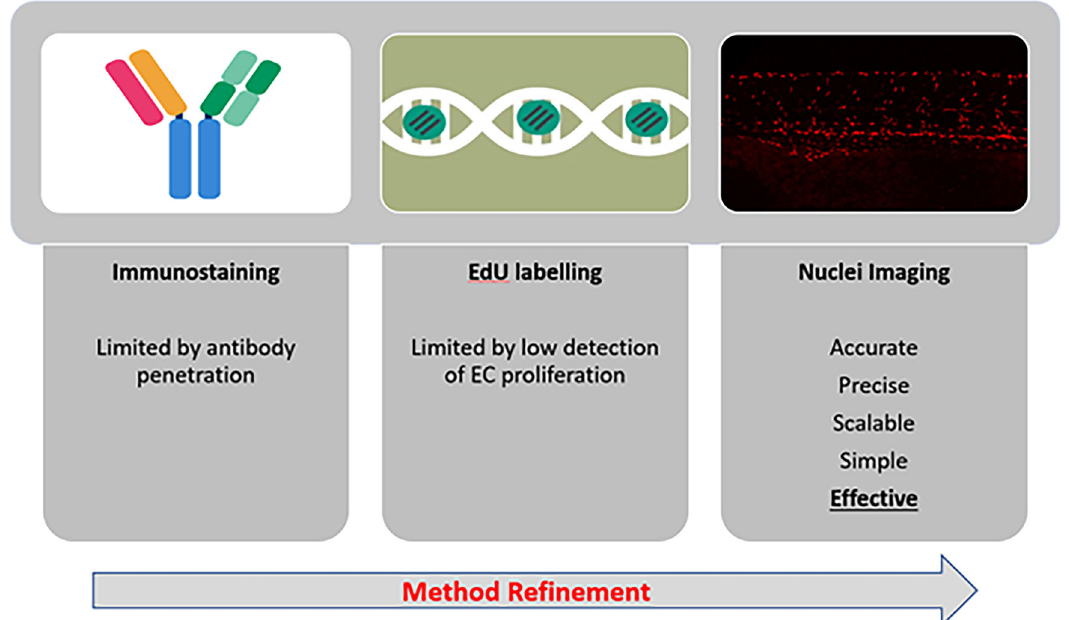
Figure 7.Graphical abstract. Immunostaining (forPCNA)islimitedbyantibodypenetration.EdUlabellingislimited by low detection of EC proliferation, the toxic effects of EdU treatment (which necessitates DMSO) prevent longer incubation times. Nuclei imaging by time-lapse microscopy is effective for studying EC